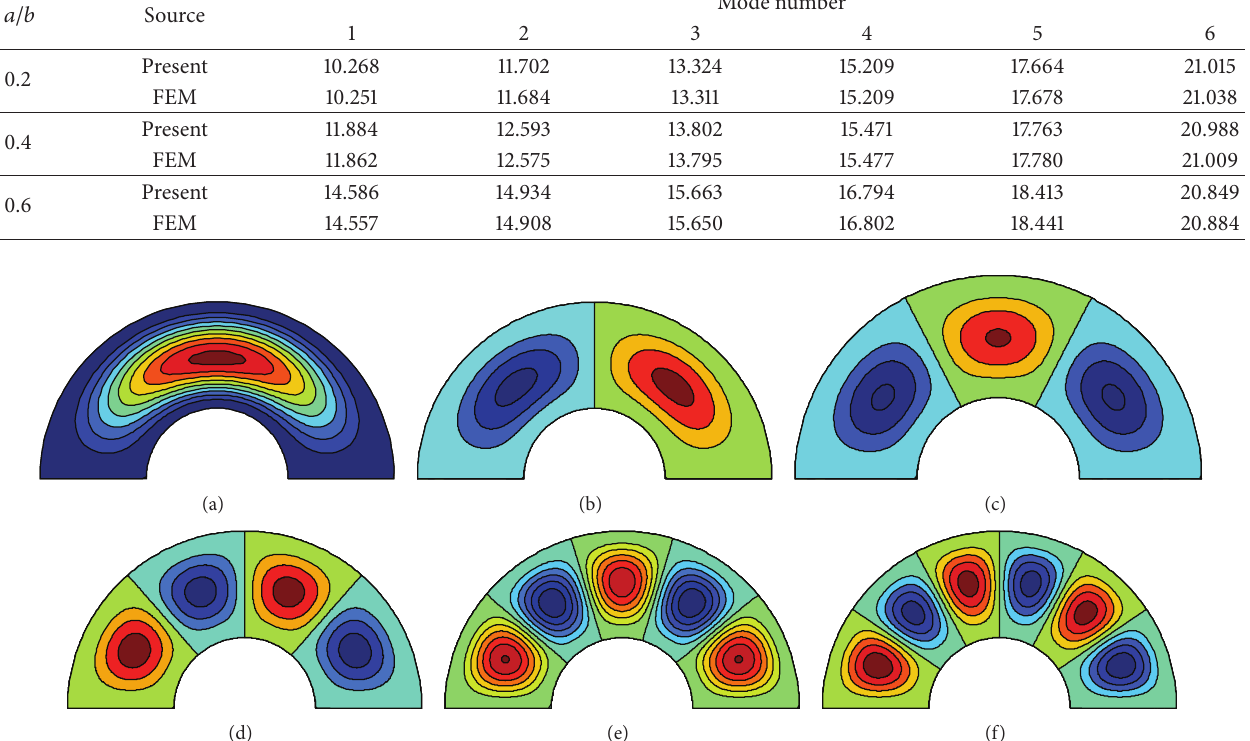
Figure 2: The first six mode shapes for a CCCC annular sector plate (𝑎/𝑏 = 0.4 and 𝜙 = 𝜋) : the (a) first, (b) second, (c) third, (d) fourth, (e) fifth, and (f) sixth mode